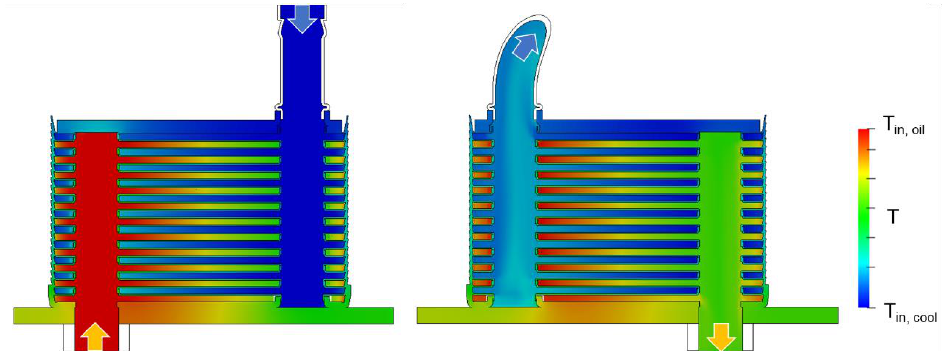
Figure 16. Cooler A: Temperature distribution across two planes passing through inlet and outlet ducts. Operating conditions: Q oil = 50%, Q cool = 80%.